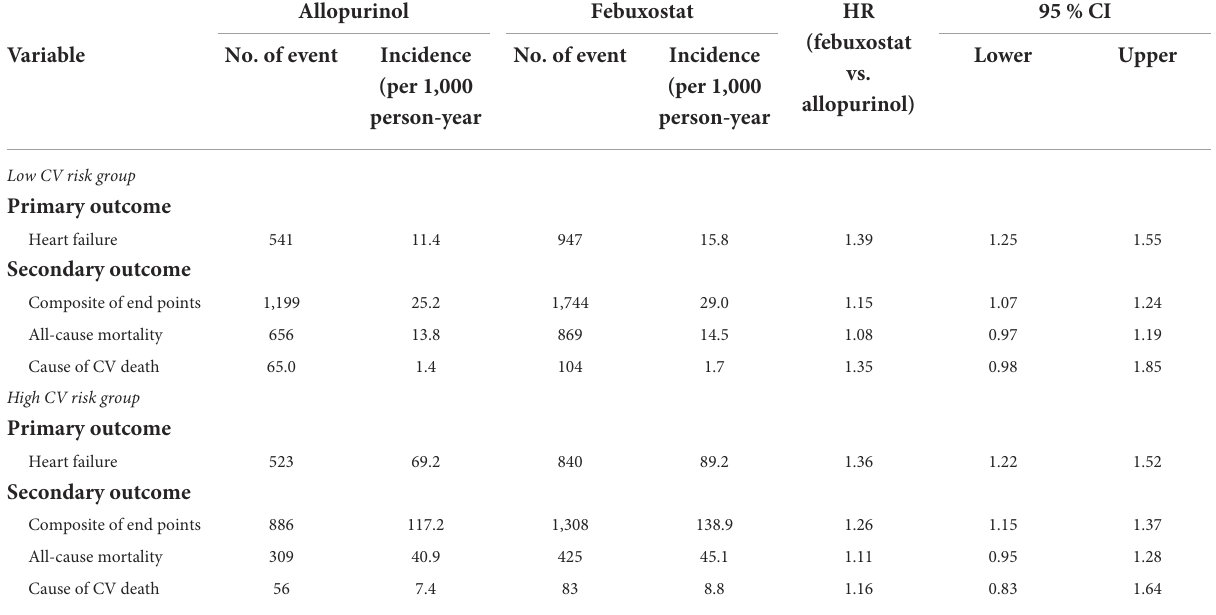
TABLE 2 Hazard ratios of heart failure, composite of end points, all-cause mortality, and cause of CV death between patients taking allopurinol and febuxostat. Variable No. of event Incidence